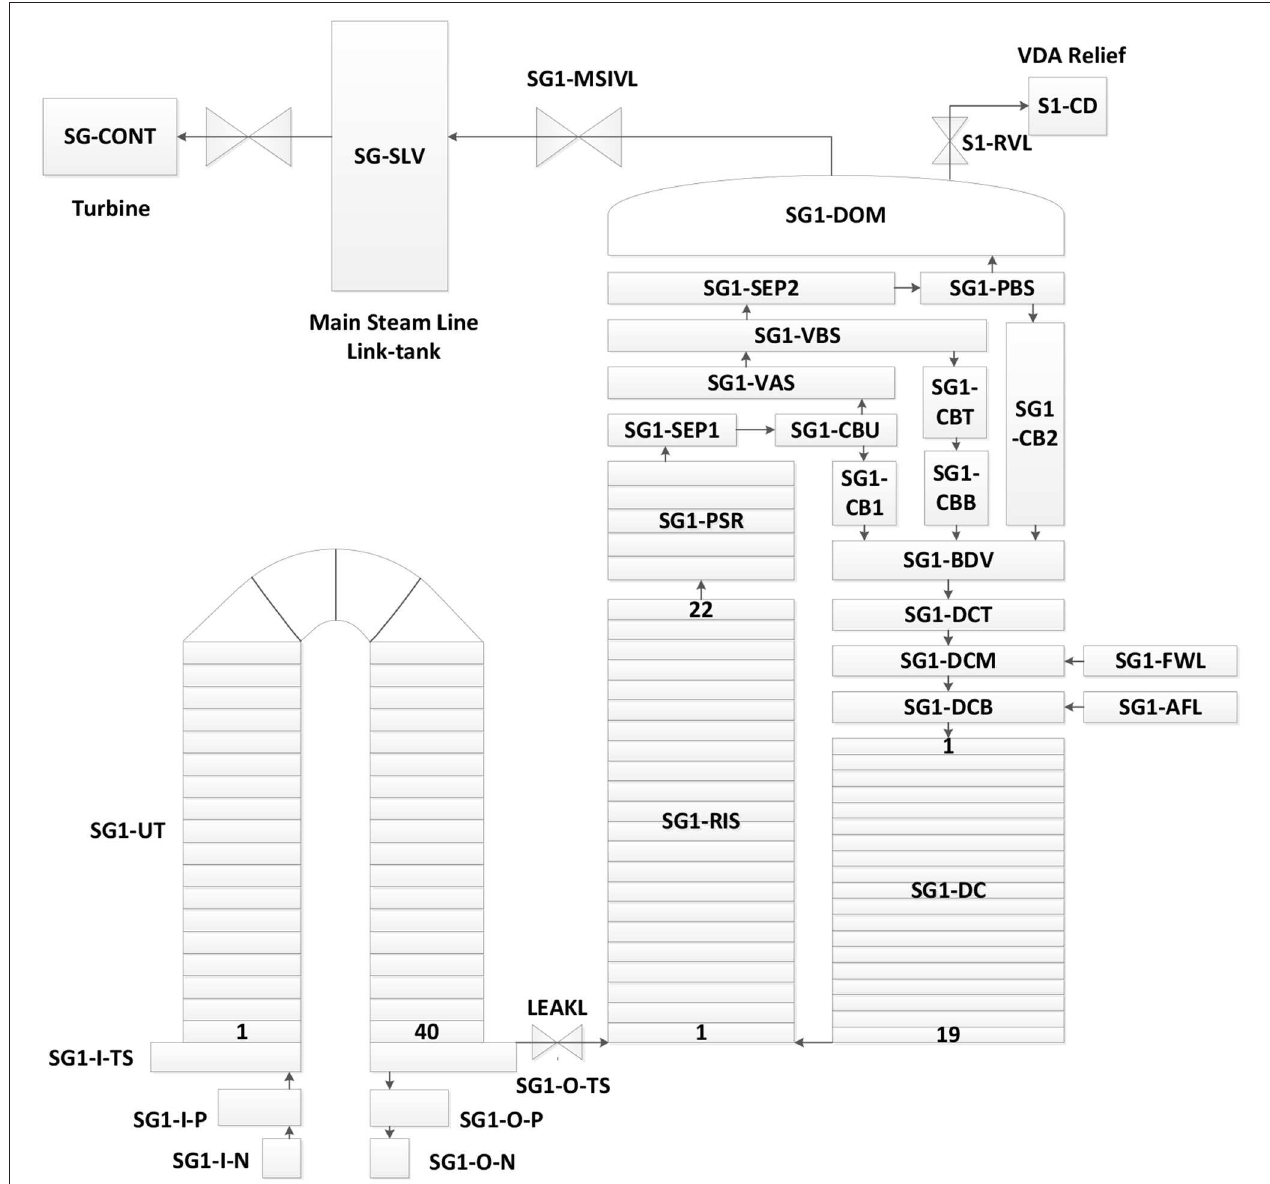
FIGURE 7 | The nodalization scheme of SGTR for